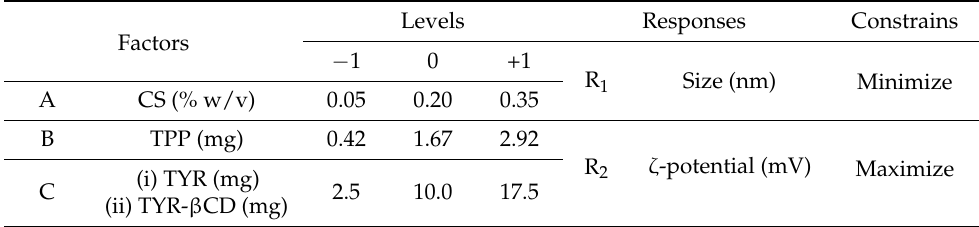
Table 1. Factors, level and responses of the DoE studies. Factors